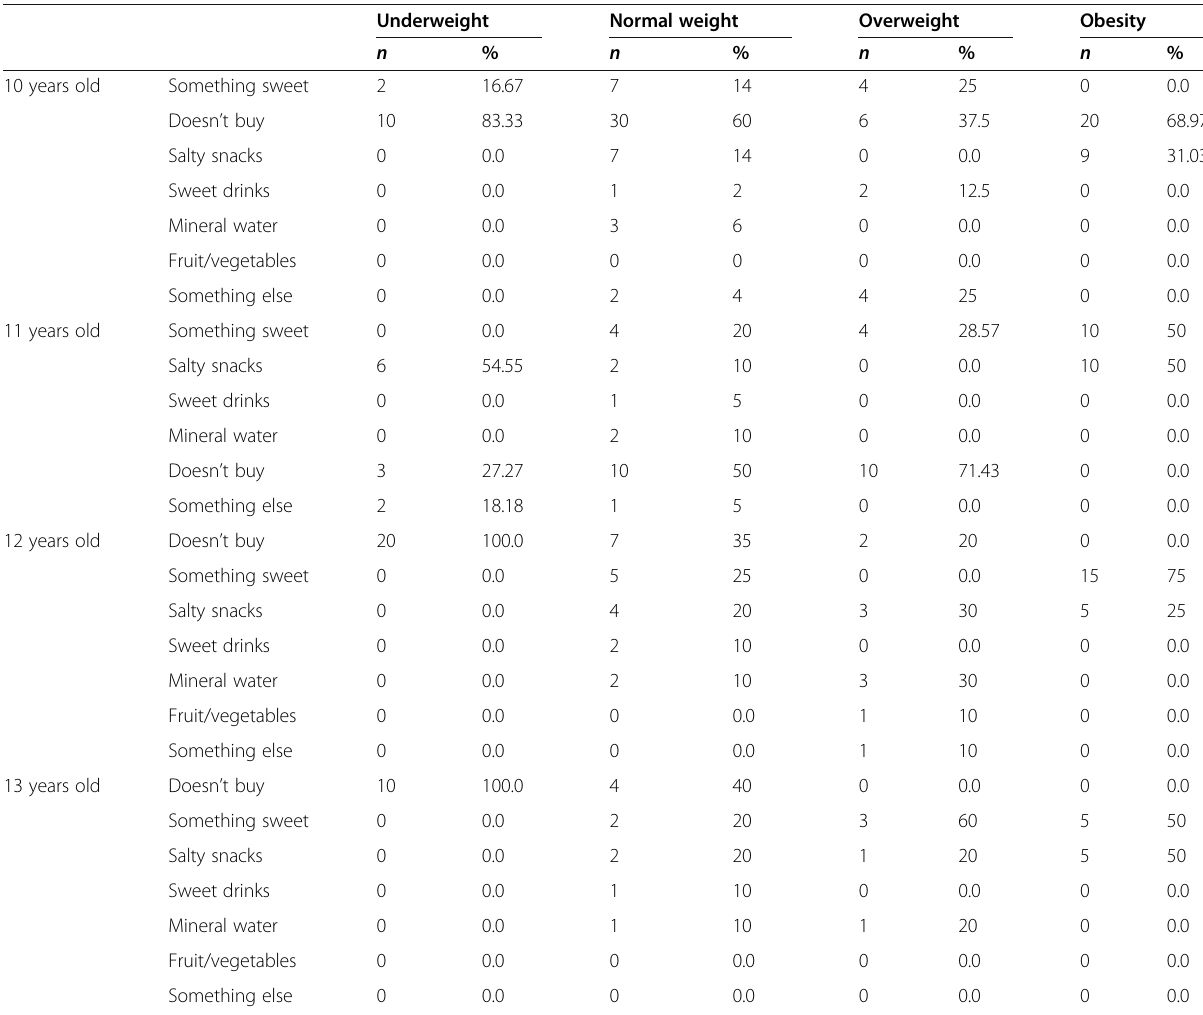
Table 11 The products bought in a school shop in a group of boys depending on age and BMI level (underweight, normal weight, overweight, obesity) Underweight Normal